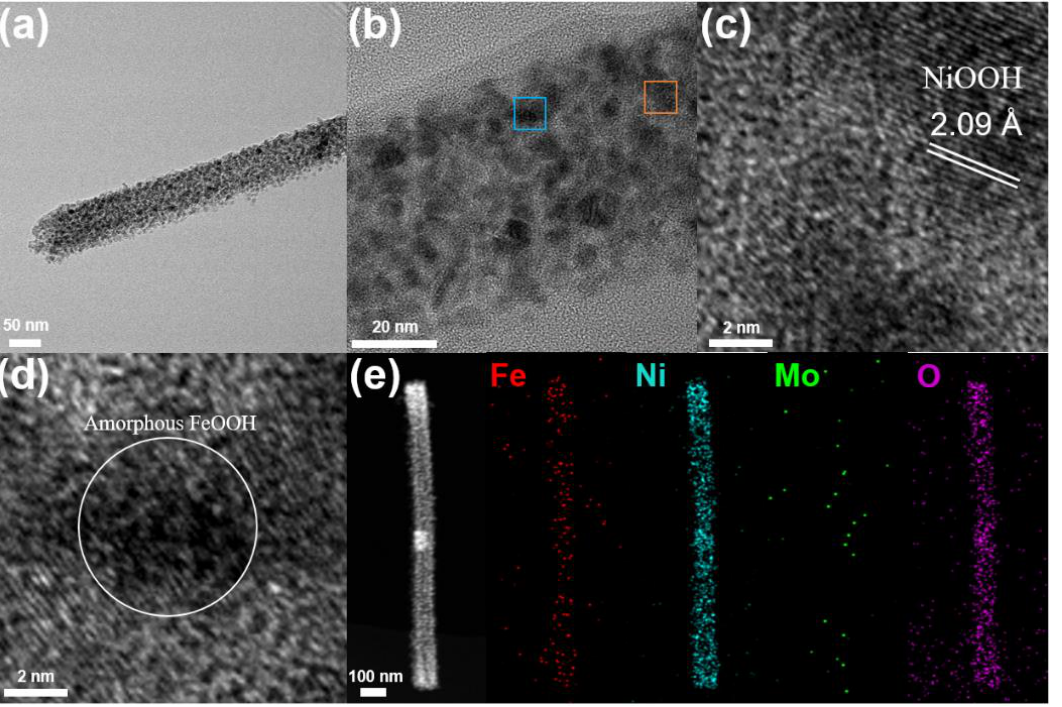
Figure 6. ( a ) TEM image; ( b ) HRTEM image of NiFe 2 O 4 /NiMoO 4 after 3 h of OER testing; ( c ) the corresponding HRTEM images of the area selected by the orange frame; ( d ) the corresponding HRTEM images of the area selected by the blue frame; and ( e ) EDS mapping images for Fe, Ni, Mo, and O elements of NiFe 2 O 4 /NiMoO 4 after OER.